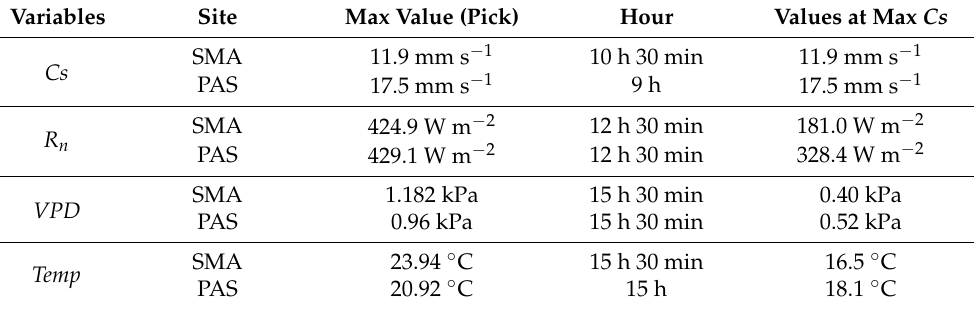
Figure 7. Hysteresis loops between surface conductance ( Cs , mm s − 1 ) and the environmental variables of net radiation ( Rn , W m − 2 ); vapor pressure deficit ( VPD , kPa), and air temperature ( Temp , °C) for the ( a , c , e ) SMA and ( b , d , f ) PAS sites, from 1 September 2014 to 1 September 2016. Table 4. Maximum values and respective hour for the surface conductance Cs (mm s − 1 ), net radiation ( Rn , W m − 2 ), air temperature ( Temp , °C), and vapor pressure deficit ( VPD , kPa) occur for the Pampa biome, at the SMA and PAS sites, in the average daily cycles, from 1 September 2014 to 1 September 2016.